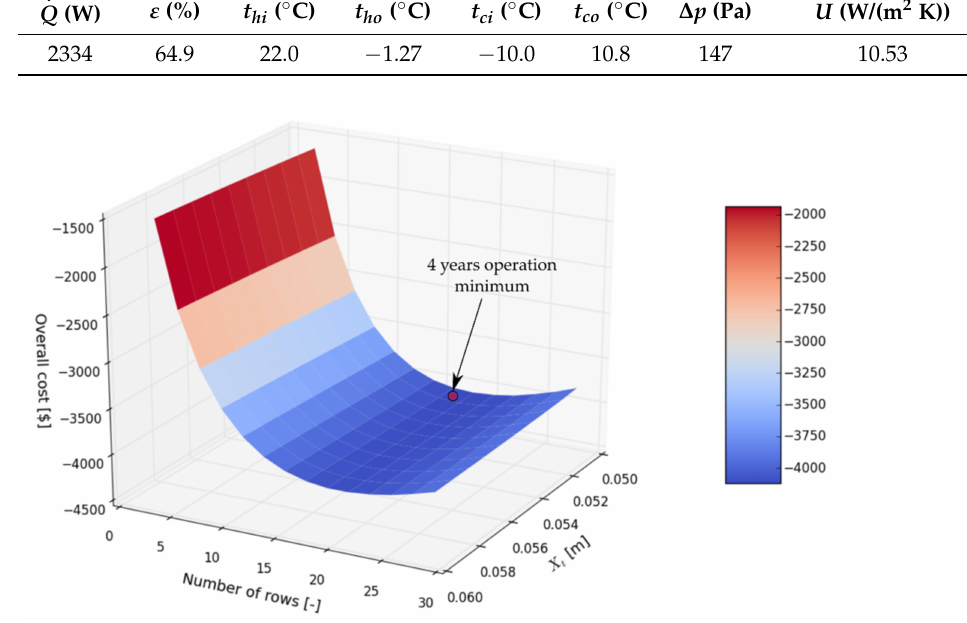
Figure 26. The overall cost of 4 years of operation of HPHE as a function of number of rows and traversal HPs